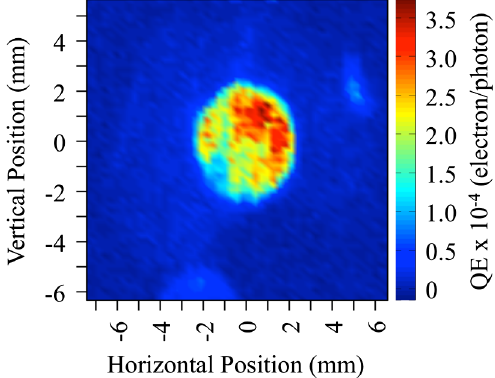
FIG. 3. Quantum efficiency map from CsBr following activa- tion taken at − 60 ° rf phase, 80 MV = m field, 5 uJ laser pulse energy. The 5 mm CsBr disk on axis is clearly resolved and shows an order of magnitude higher quantum efficiency than that of the surrounding